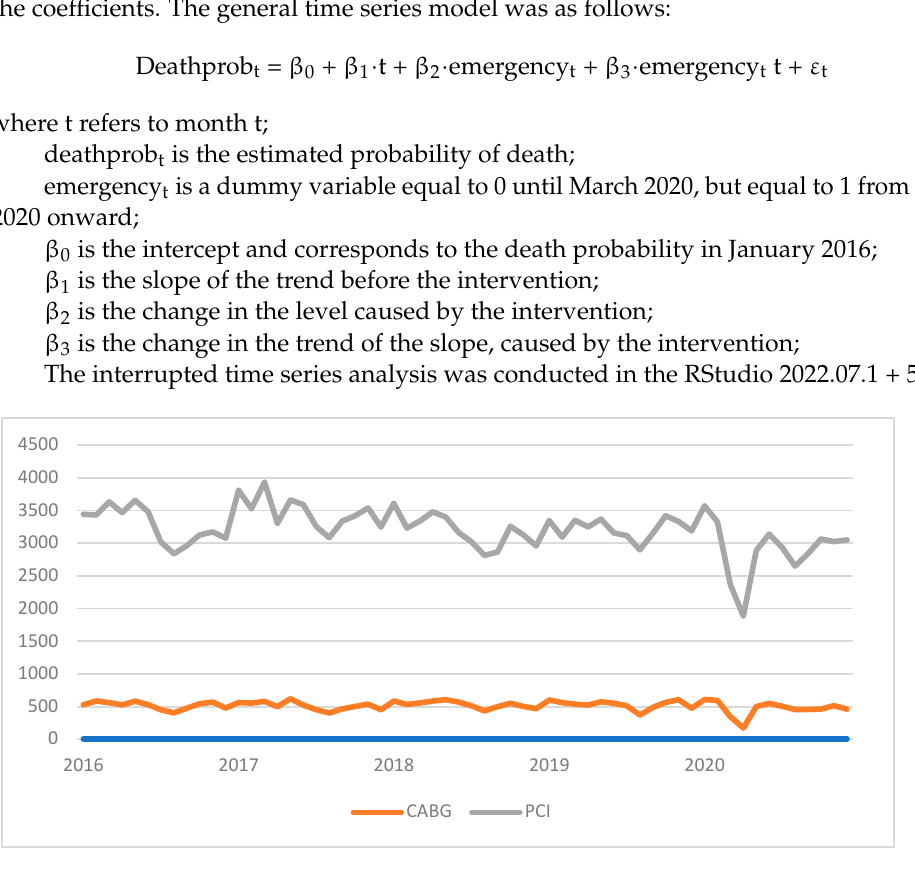
Figure 1. Time trends of coronary revascularizations in Spain.